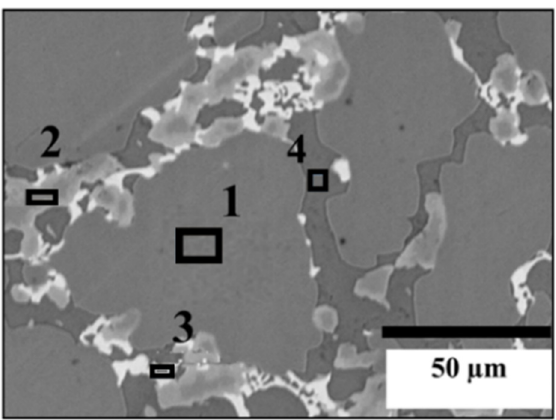
Figure 4. EDX analysis of TiFe alloy with the simultaneous addition of 2 wt.% Zr + 2 wt.% V + 2 wt.% Mn. Table 4. Chemical composition of TiFe + 2 wt.% Zr + 2 wt.% V + 2 wt.% Mn (uncertainty on all values is ± 1). Alloy Ti (at.%) Fe (at.%) V (at.%) Zr (at.%) Mn (at.%) TiFe + 2 wt.% Zr + 2 wt.% V + 2 wt.% Mn Area 1(grey phase)